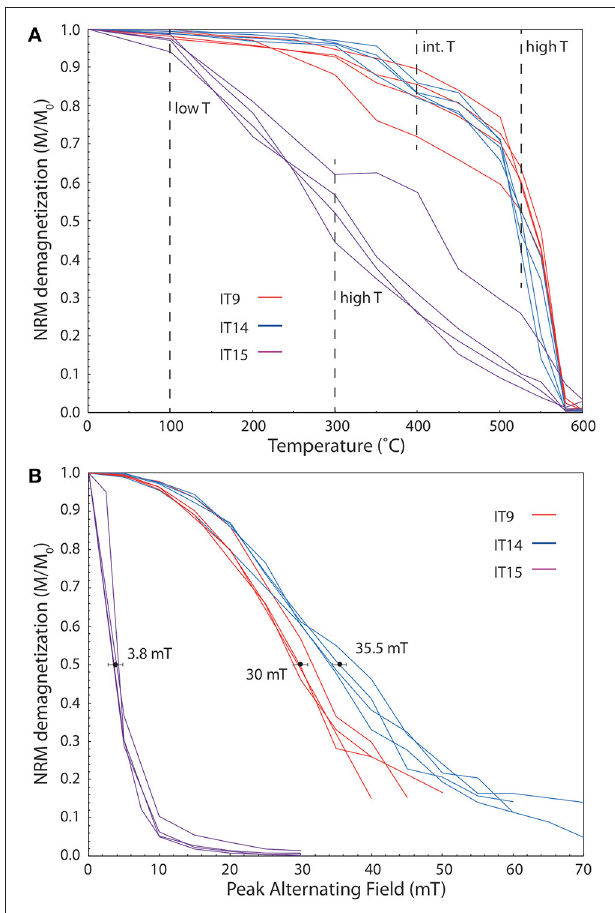
FIGURE 4 | (A) Thermal demagnetization of the NRM of the mafic sills, specimens from IT9, IT14, and IT15 are the red, blue and purple curves, respectively; vertical dashed lines indicate the temperature ranges at which the intermediate and high temperature components were isolated; (B) AF demagnetization of the mafic sills, colors as in (A) ; the mean median destructive fields are reported with 1 standard deviation error bars. See text for